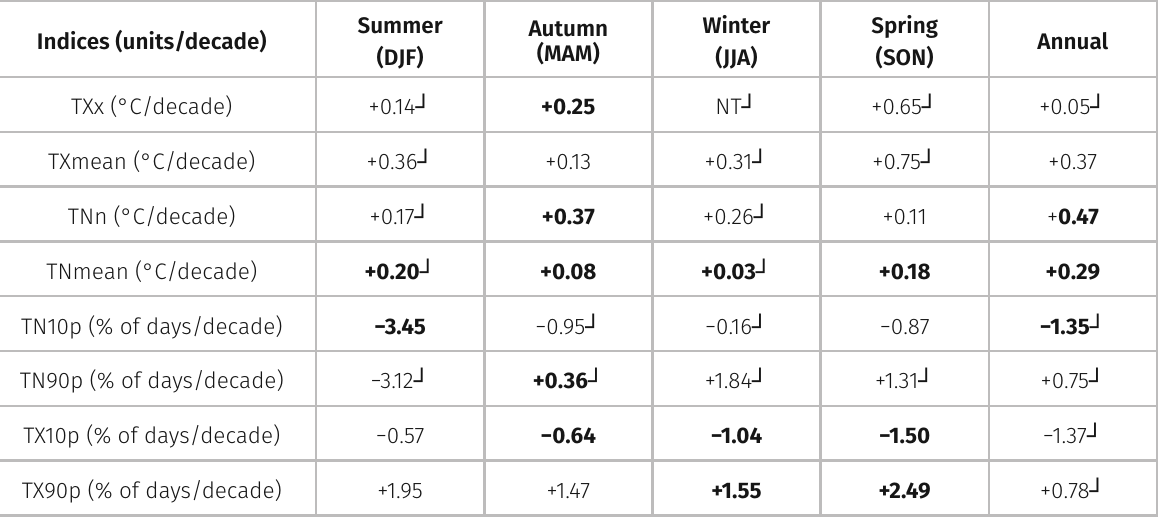
Table II. Seasonal and annual trends of temperature indices from 1968 to 2017. Trends highlighted in bold are statistically significant at 95% significance level. Negative values indicate decreased trends, whereas positive values indicate increased trends. NT: No trend or values equal to zero. ┘ : Trends recorded for data series after discontinuity points were identified in Figure